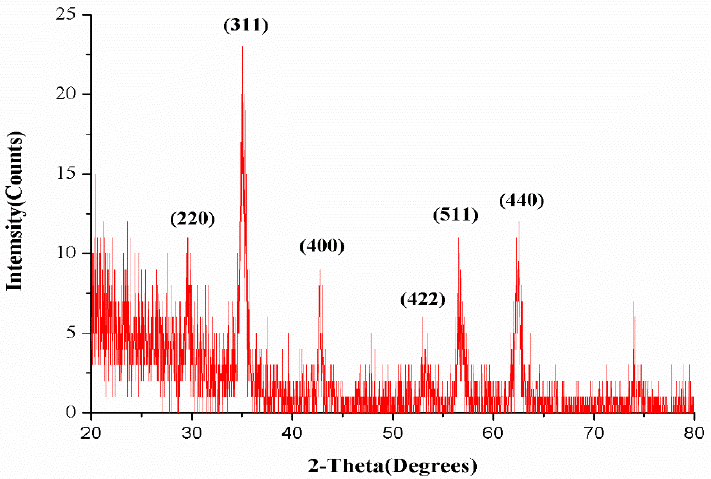
Figure 2. XRD (X-ray diffraction) graph of Fe 3 O 4 nanoparticles.